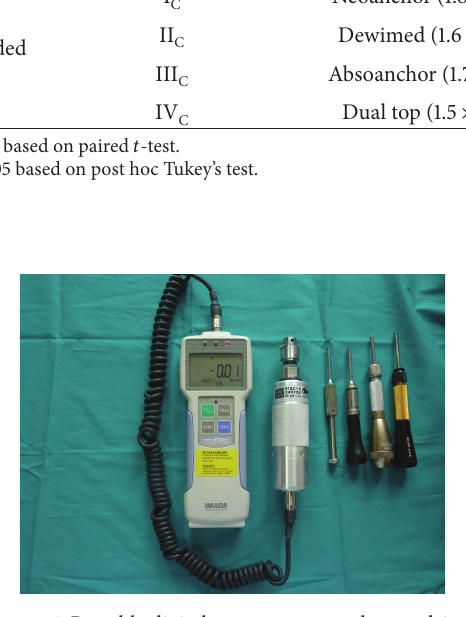
Figure 4: Portable digital torque gauge and screwdrivers.